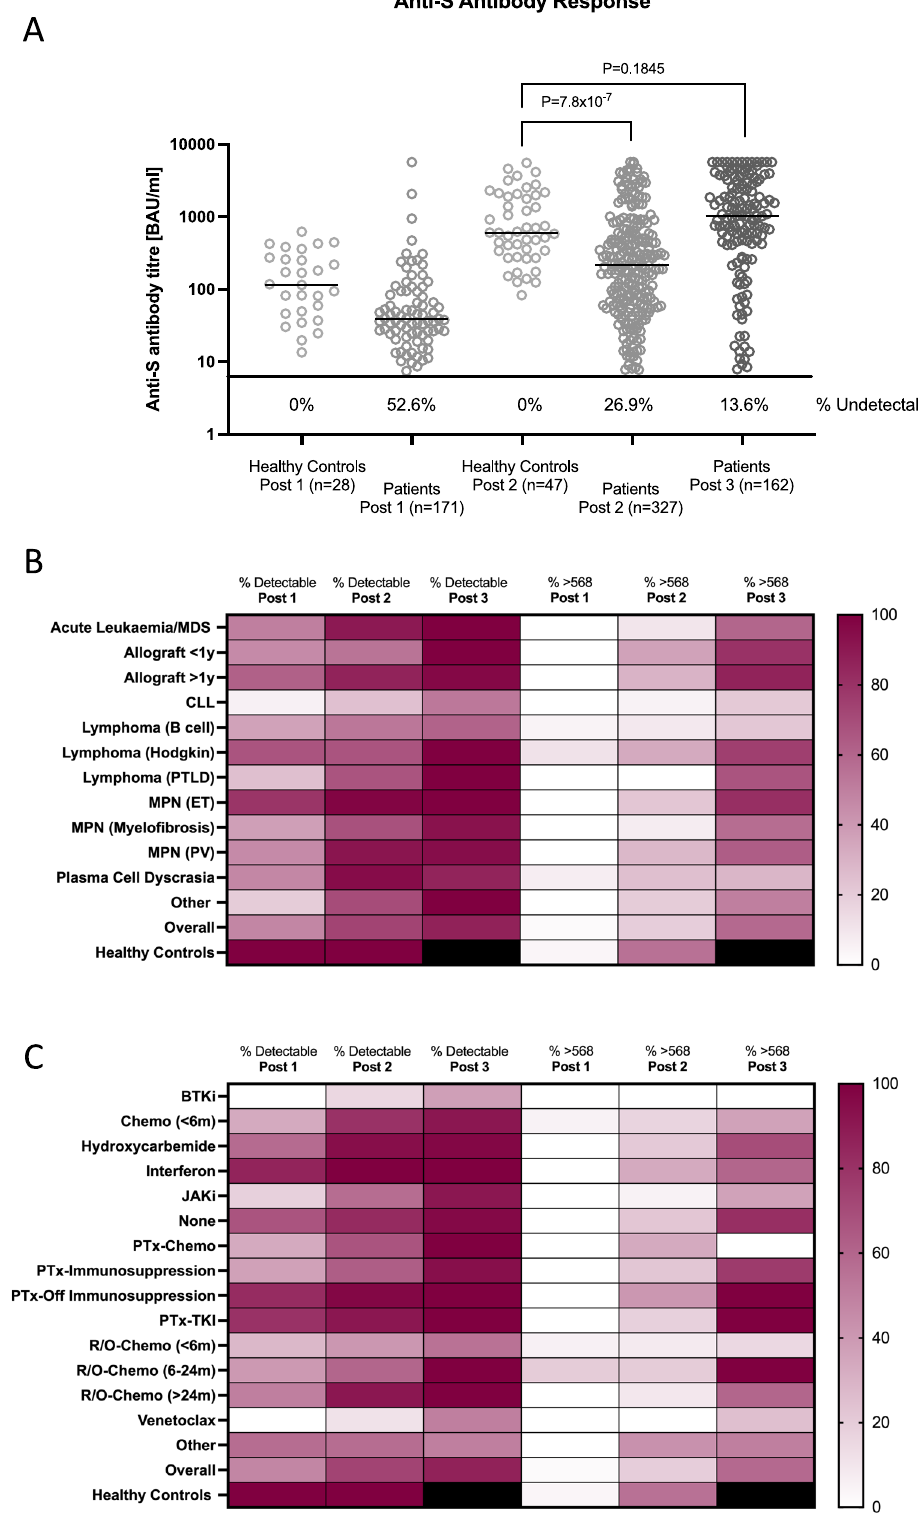
Fig. 1 | Serological responses to SARS-CoV-2 vaccination in patients with hae- matological malignancies. A Anti-S antibody titres following 1, 2 and 3 vaccines dose in patients, and following 1 and 2 in healthy controls, bar denotes median. B Heatmap showing the percentage of patients with detectable anti-S antibodies (>7.1 BAU/ml) and antibody response greater thanthe bottom 10% of the antibody range (>568 BAU/ml) strati fi edby disease type. C Heatmapstrati fi ed by treatment. BAU binding antibody units, MDS myelodysplastic syndrome, CLL chronic